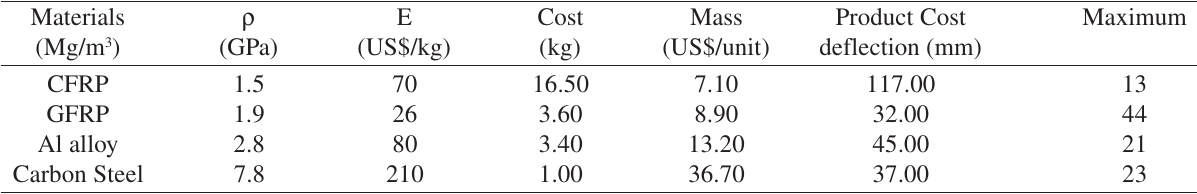
Table 1. Relevant properties of selected materials and performance